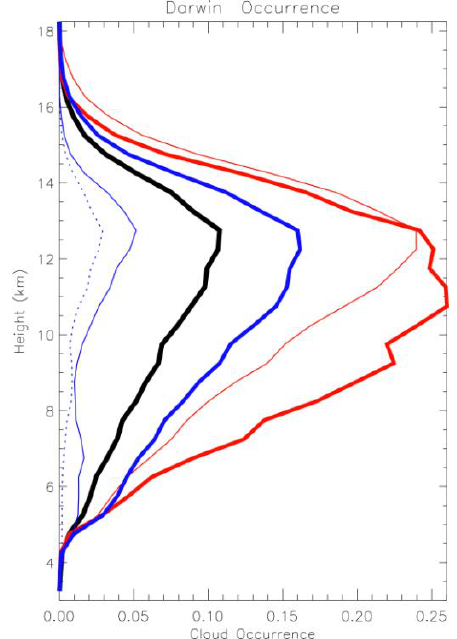
Figure 1: Vertical profile of the frequency of ice cloud occurrence over Darwin with all regimes included (thick black line), and for the following large-scale atmospheric regimes: Moist Easterly (thick blue line), Easterly (thin solid blue line), Dry Easterly (thin dotted blue line), Active monsoon (thick red line), and Shallow Westerly (thin red line).